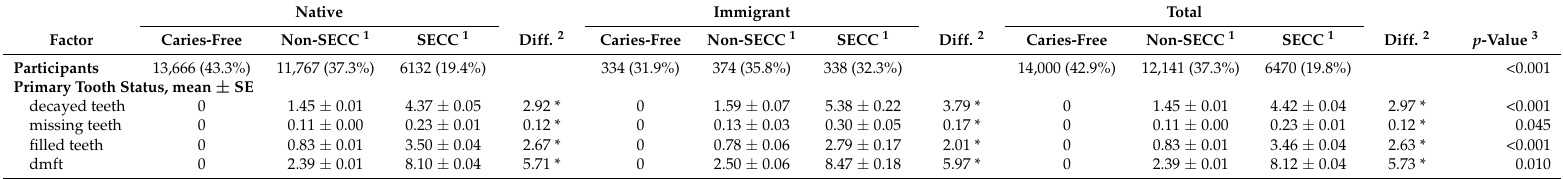
Table 1. Primary tooth status of children aged 3–5 years in relation to dental caries status in native and immigrant participants.